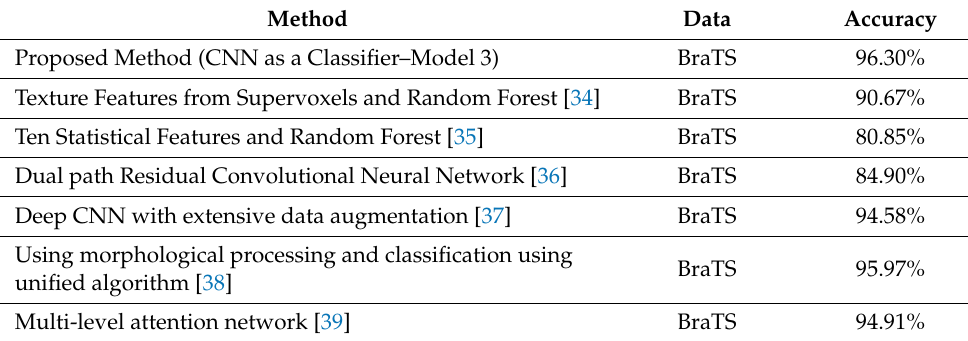
Table 14. Comparison of the proposed method for multiclass Glioma Tumor Classification with literature